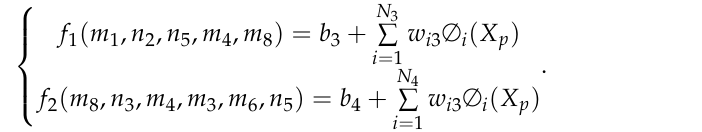
Table 2. Evaluation indicators for model.